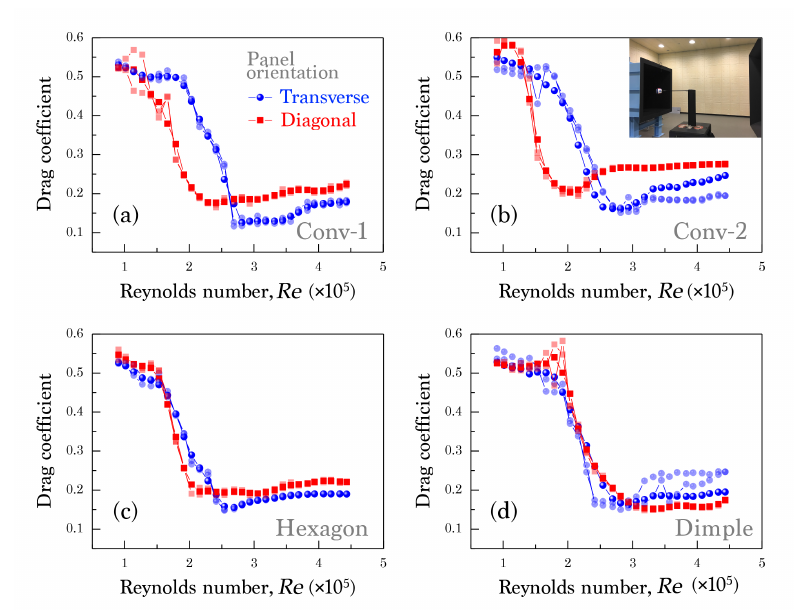
Figure 2. Drag crisis of volleyballs. Circles and squares represent transverse and diagonal directions, respectively, with different surface patterns: ( a ) Conv-1, ( b ) Conv-2, ( c ) Hexagon and ( d ) Dimple. Inset shows the wind tunnel experiment. To check out the experimental uncertainty, three data were included for each case. Discrepancy in drag crisis appears in conventional balls, while similarity in drag crisis in balls with isotropic patterns.